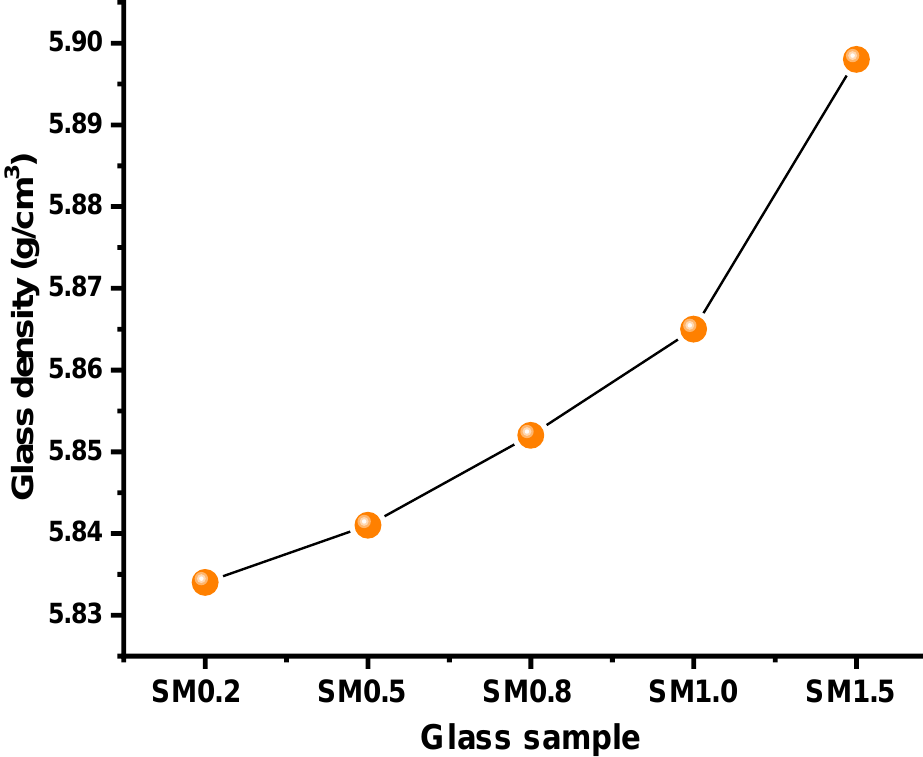
Figure 3. Variation of glass densities as a function of glass type (i.e., Sm 2 O 3 %mole). At this moment, Figure 4 depicts the changes in µ values as photon energy (MeV) function. From 0.015 MeV to 0.03 MeV, a sharp decrease was seen. Following that, a sharp peak near Te’s k-absorption edge was found. This demonstrates that Te is present in all glass samples. We would like to emphasize that the results of the glass samples were near to each other due to the low molar variations in the Sm 2 O 3 additive. Nevertheless, adding the Sm 2 O 3 additive had a synergistic impact on the linear attenuation coefficients of SM glasses. Our findings clearly showed that the SM1.5 sample has the maximum µ values at all energies. On the other hand, the term mass attenuation coefficient ( µ m ) refers to the density-independent attenuation coefficient, which contains critical information about the material’s shielding performance as a function of its elemental structure. Figure 5 illustrates the variation of µ m values in the low-energy region. Similar to the discovery of µ values, the SM1.5 sample was reported with maximum amounts. This is explained by the fact that replaced TeO 2 and Sm 2 O 3 have different elemental structures and atomic numbers, directly affecting gamma-ray attenuation